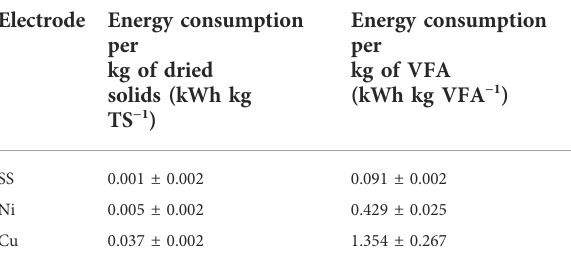
TABLE 2 Comparison of the energy consumption of E-WAS for VFA production implementing SS, Ni and Cu electrodes at 1.35V, 35 ° C and 2 h operation